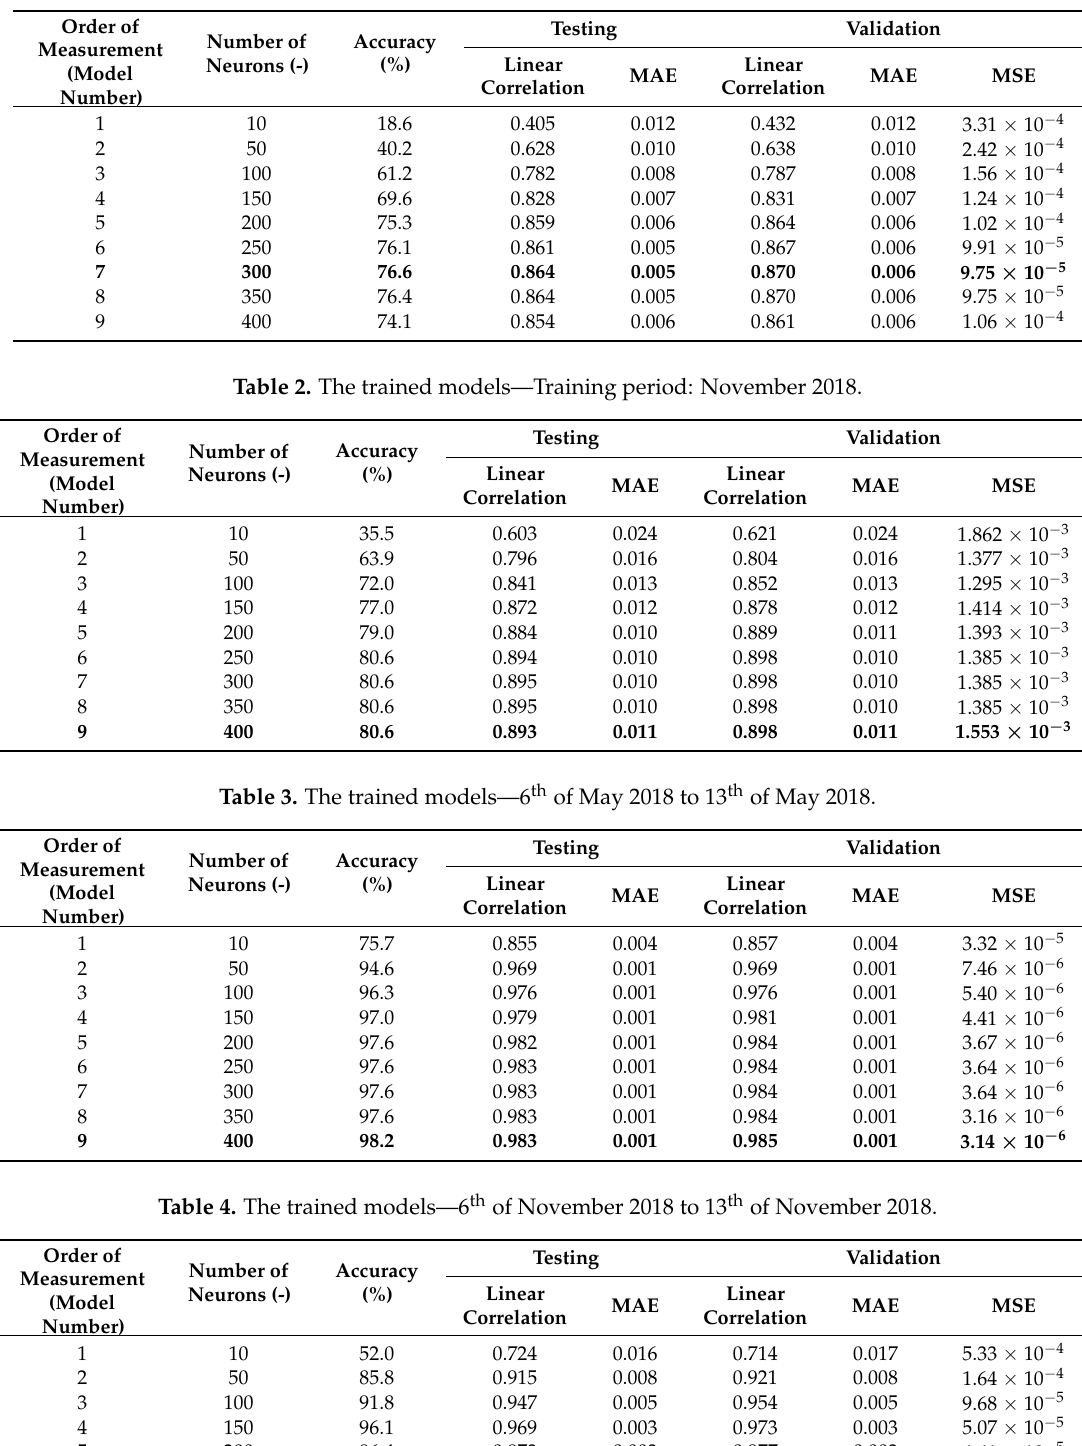
Table 1. The trained models—Training period: May 2018.